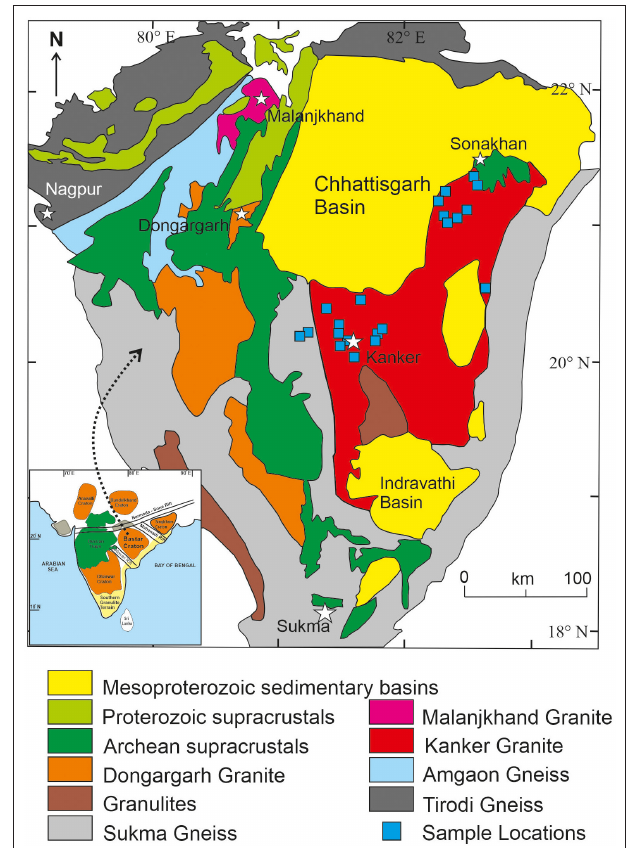
FIGURE 1 | Generalized geological map of the Bastar Craton, with the sample locations (modified after Mohanty, 2015). Inset map of Peninsular India, to show the major cratonic